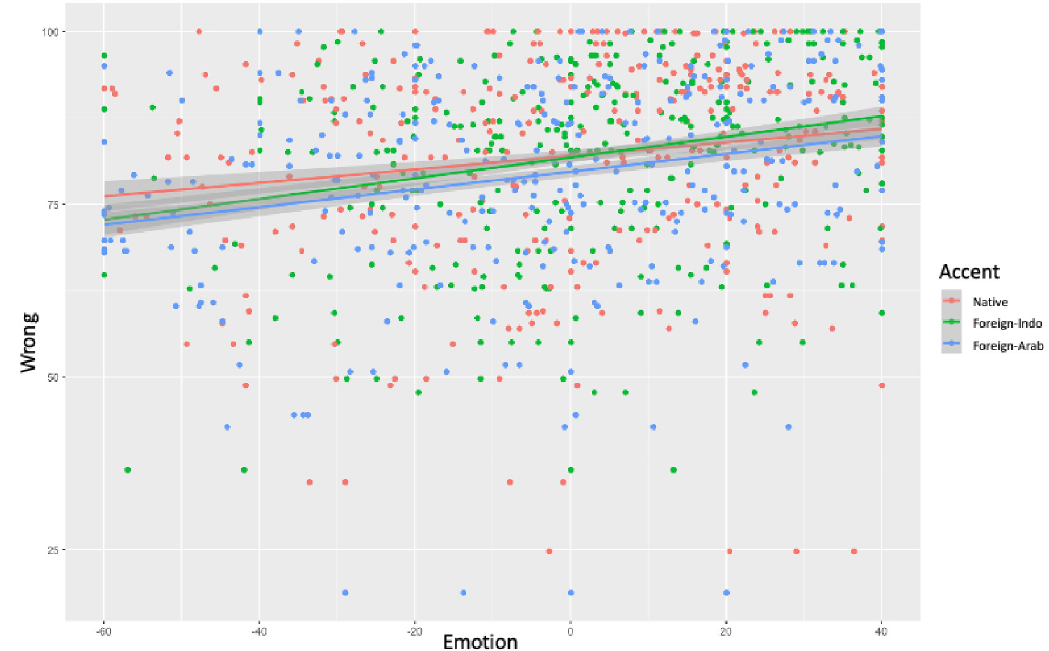
Fig 2. Interaction between Accent (Native Accent vs. Foreign-Indo vs. Foreign-Arab) and Emotion (mean for anger, disgust, discomfort, sadness, and preoccupation centered) on Wrong.